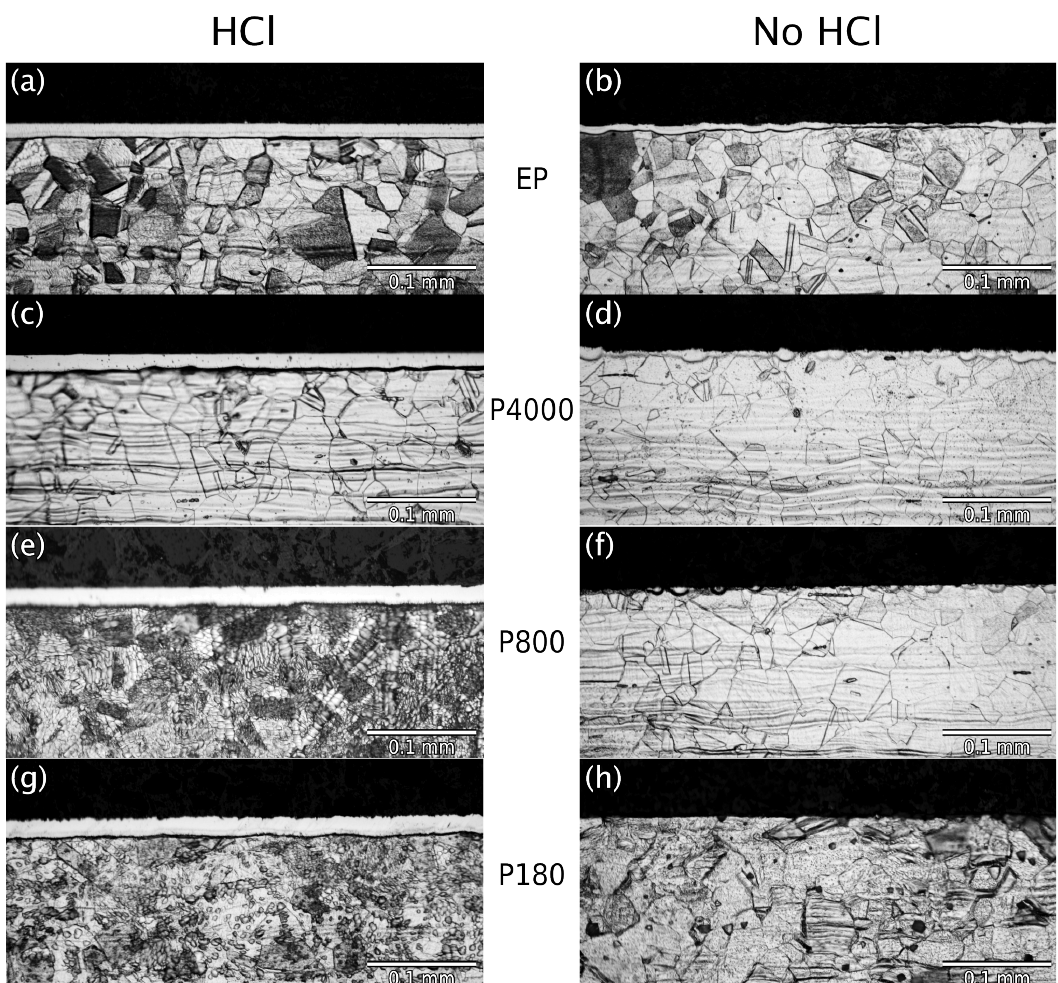
Figure 2. Cross-sectional light-optical microscopy of low-temperature-carburized AISI-AL-6XN, obtained with the following combinations of mechanical pre-preparation and chemical